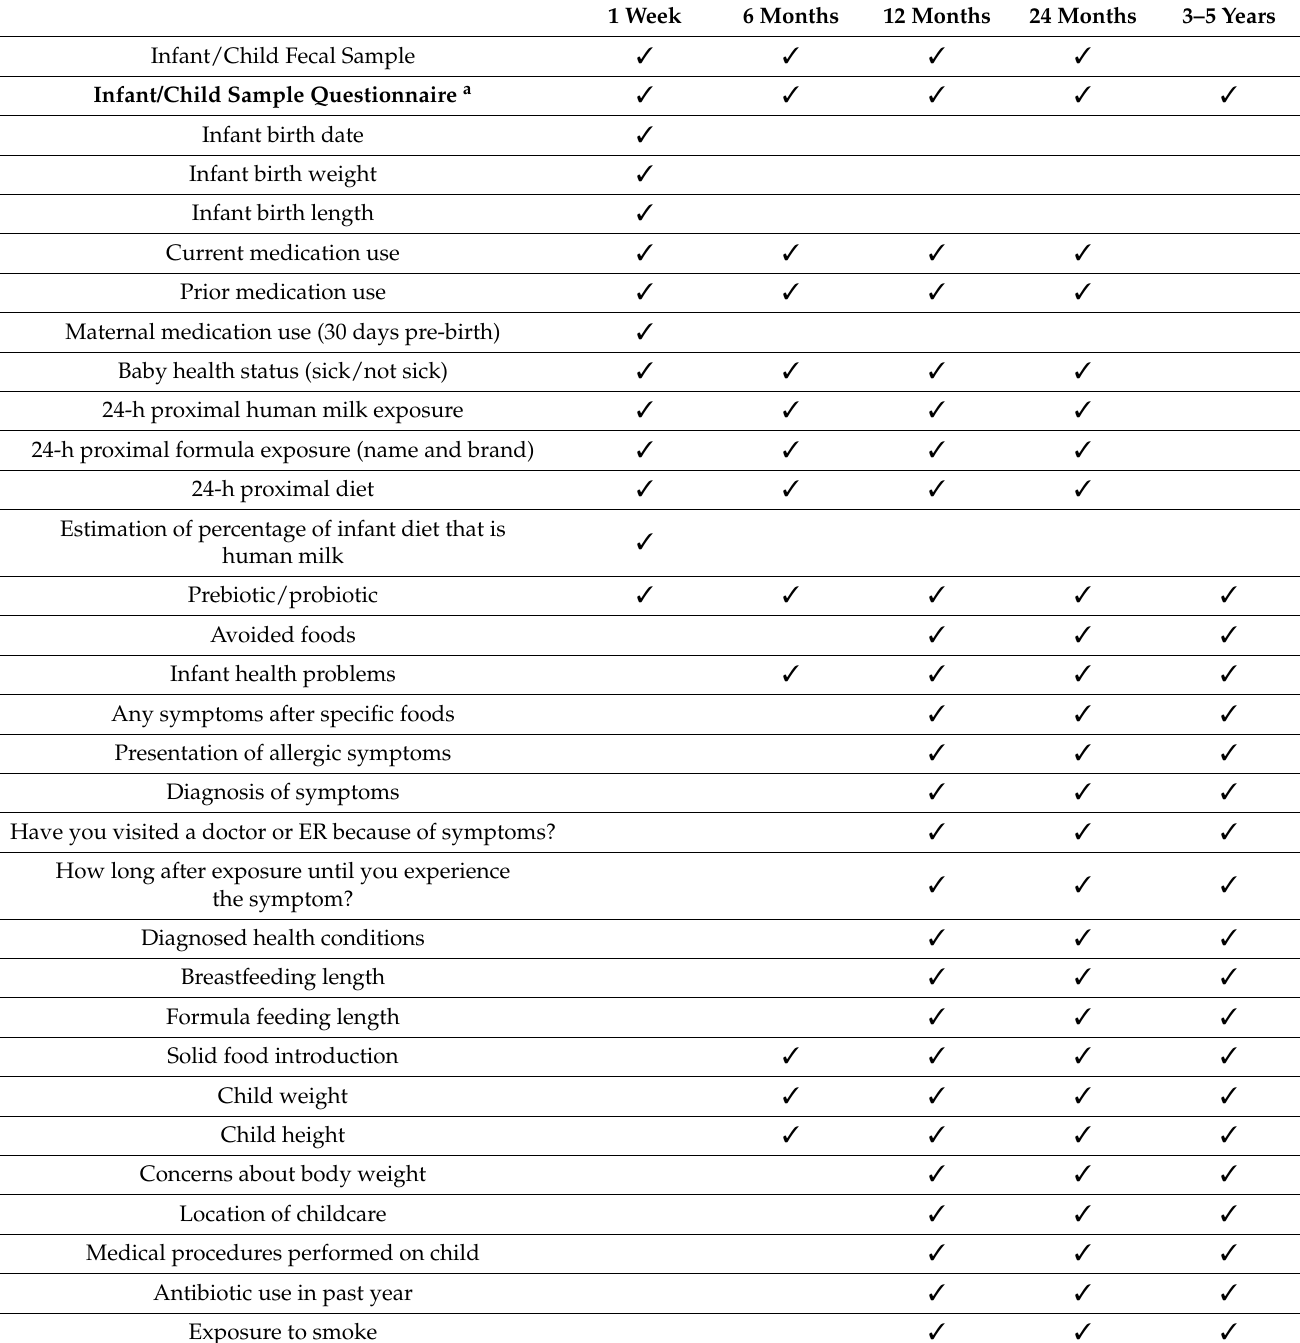
Table 2. Data and sample collection schedule for children in the ARCHBG cohort